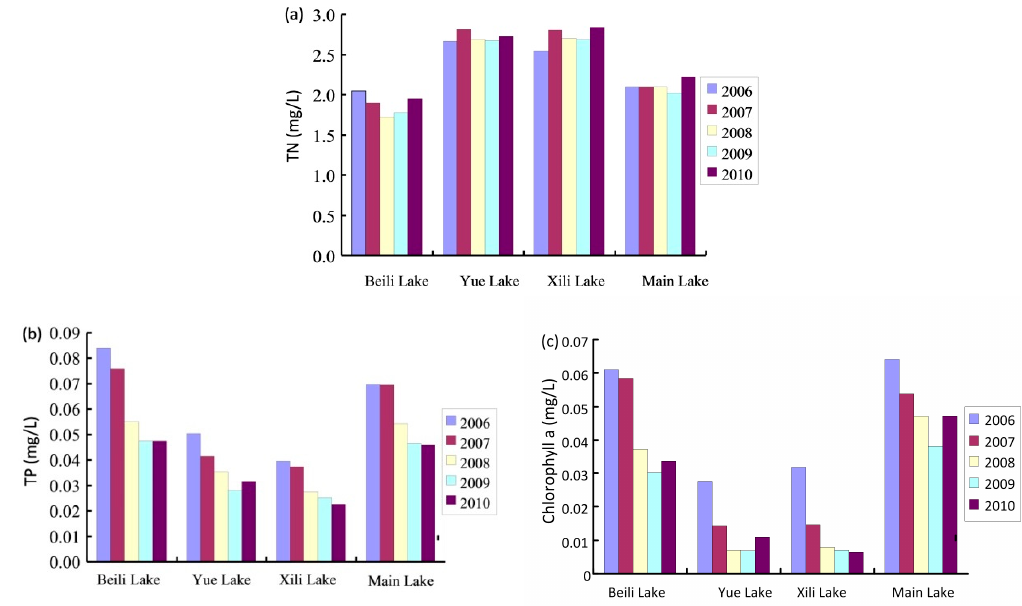
Figure 8. ( a ) Total nitrogen (TN), ( b ) Total phosphorus (TP), and ( c ) chlorophyll concentrations in the lakes from 2006 to 2010.